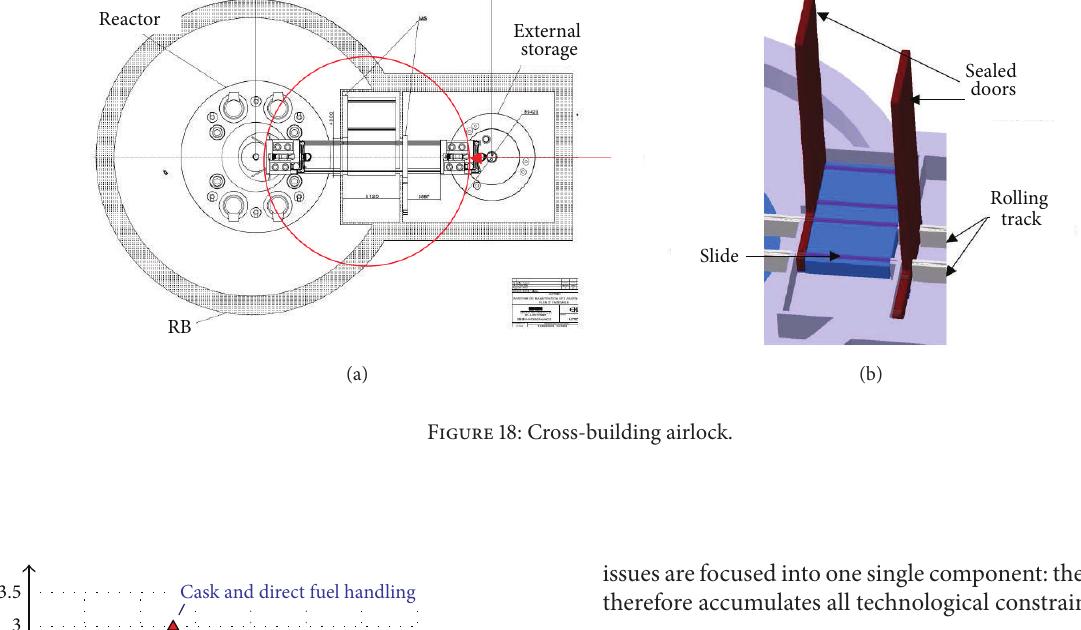
Figure 18: Cross-building airlock.